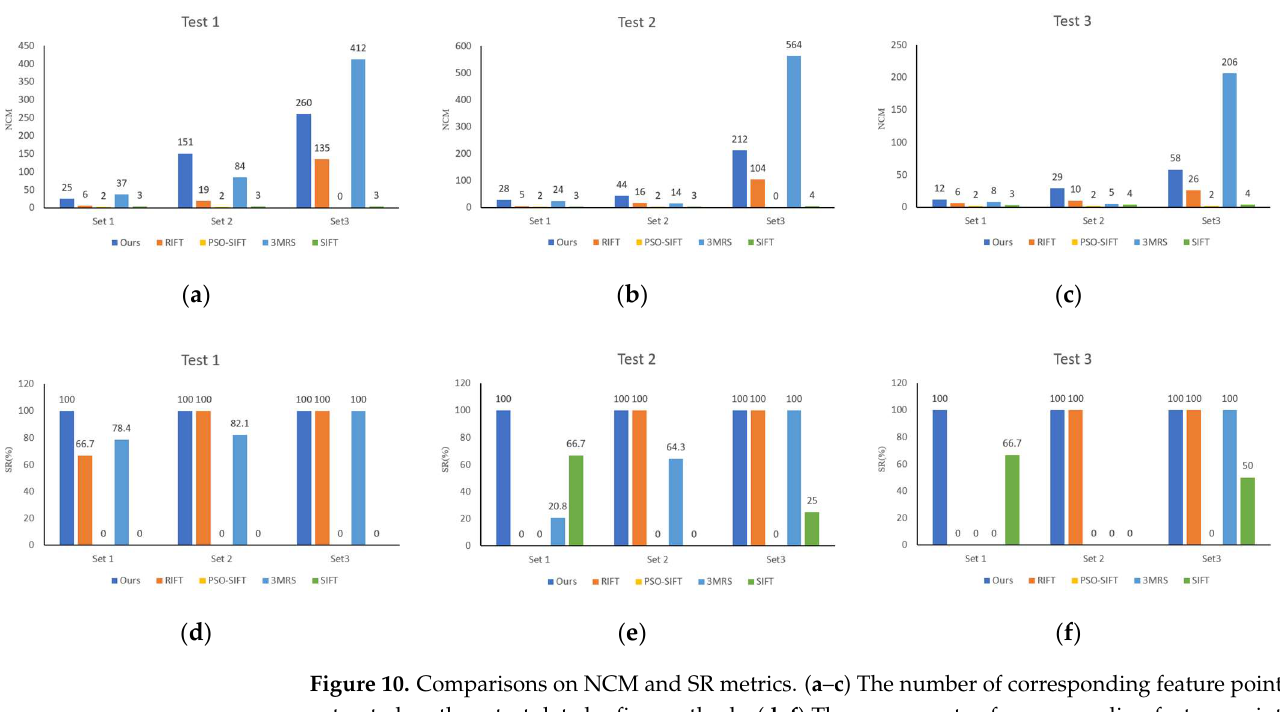
Figure 9. Comparison in the visualization results of our method, RIFT, 3MRS, PSO-SIFT, and SIFT on first test data. ( a ) The results of the proposed method; ( b ) the results of RIFT; ( c ) the results of 3MRS; ( d ) the results of PSO-SIFT; and ( e ) the results of SIFT.